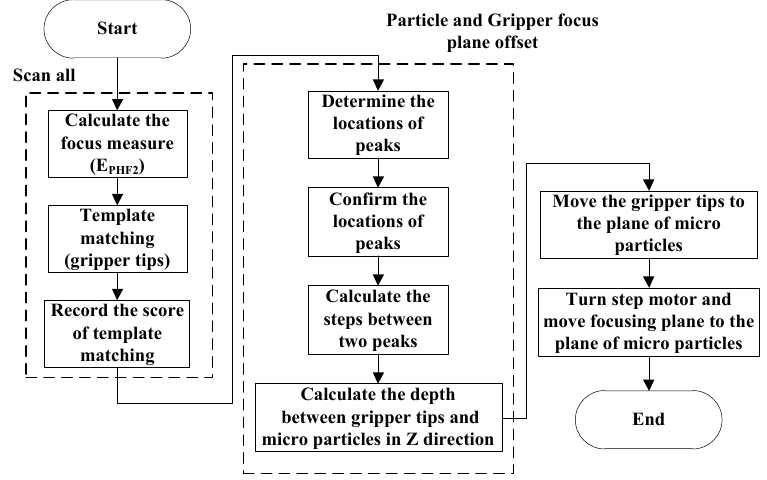
Figure 9. Flowchart of autofocusing operation to align microgripper tips and moving particles in the same focus plane (coarse adjustment).